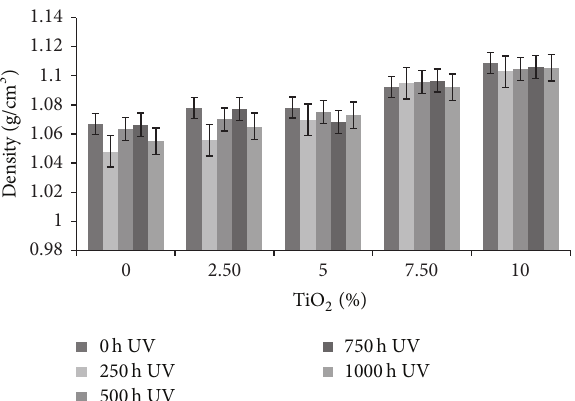
Figure 8: Density of CBC with different percentage loading of TiO 2 and UV irradiation exposure.